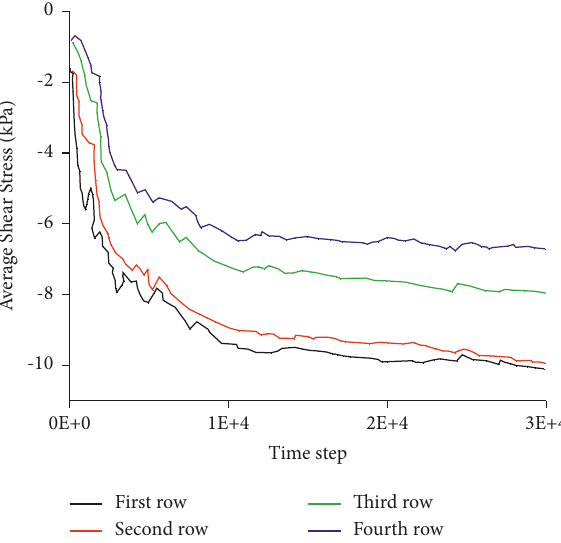
Figure 19: Average shear stress of lower